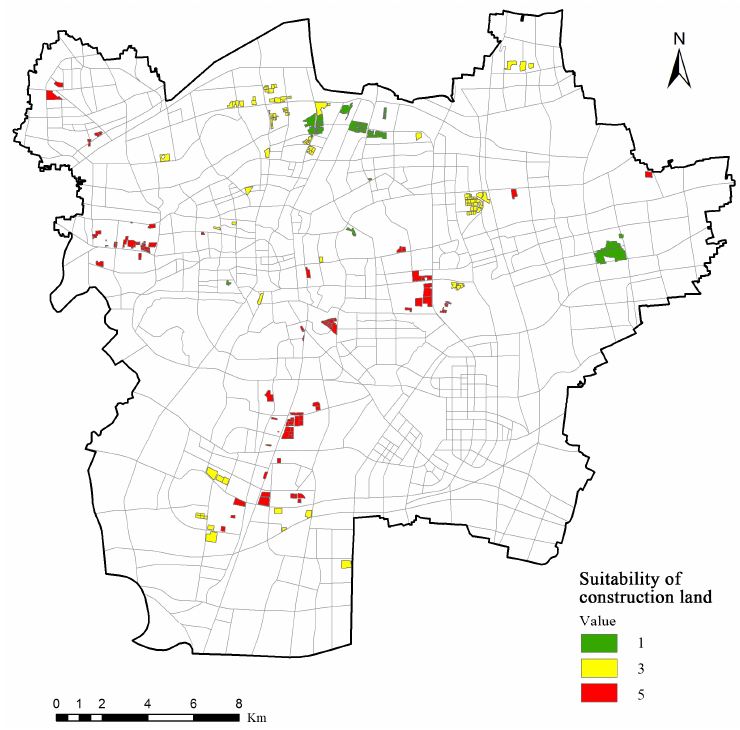
Figure A4. Single value of site suitability based on “Suitability of construction land”.